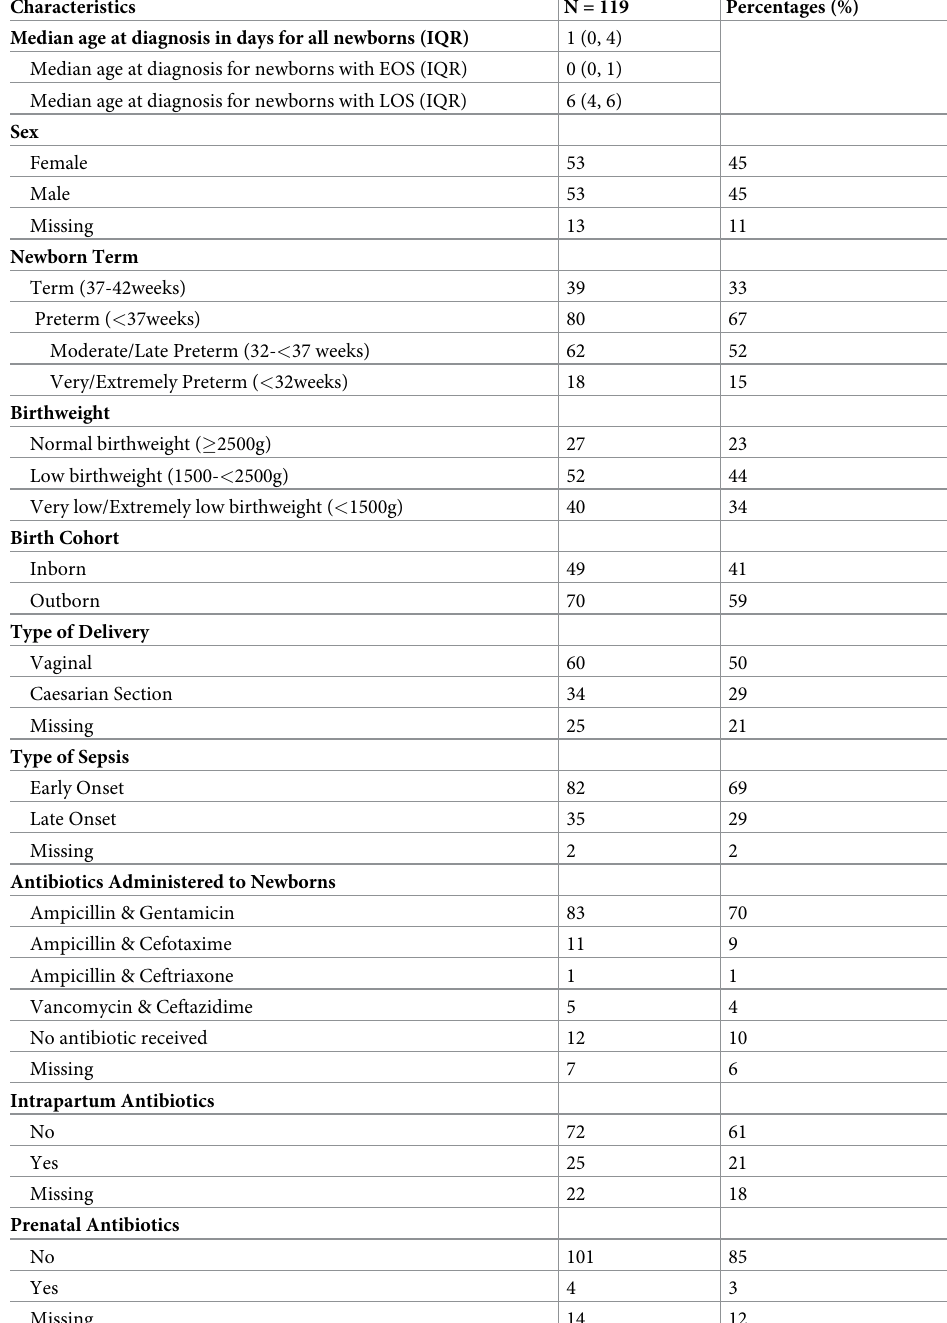
Table 1. Prevalence and risk factors for antimicrobial resistance among 119 newborns with gram-negative sepsis. Characteristics N = 119 Percentages (%) Median age at diagnosis in days for all newborns (IQR) 1 (0, 4) Median age at diagnosis for newborns with EOS (IQR) 0 (0, 1) Median age at diagnosis for newborns with LOS (IQR) 6 (4, 6) Sex Female 53 45 Male 53 45 Missing 13 11 Newborn Term Term